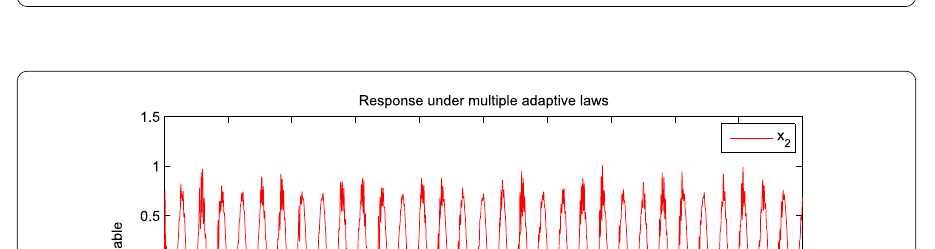
Figure 7 Tracking performances of Example 2